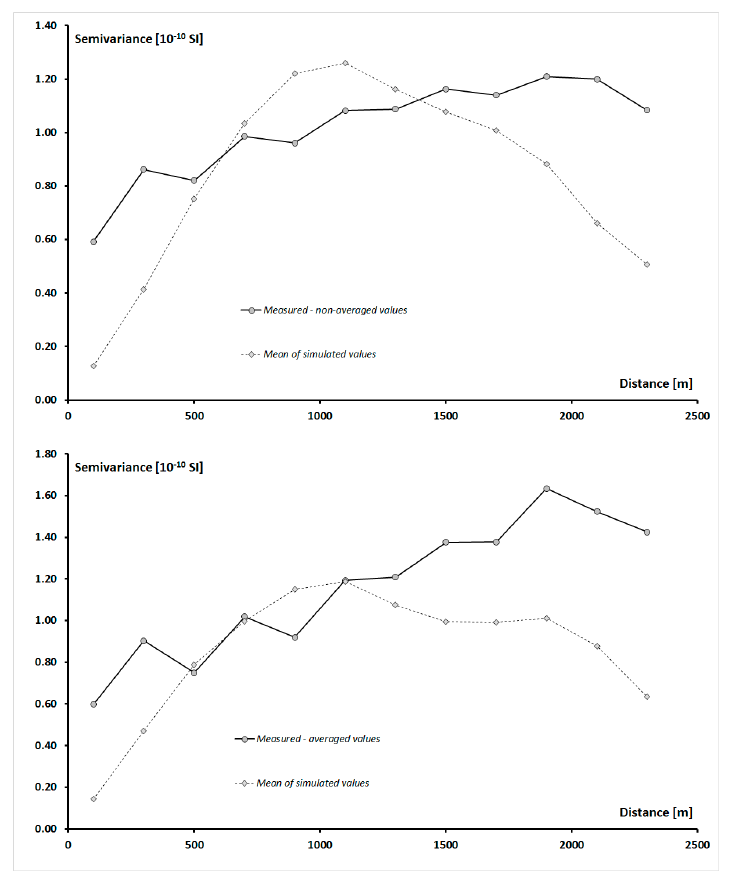
Figure 6. Experimental variograms of measured and simulated values of soil magnetic susceptibility using κ non-avg data (upper figure) and κ avg (bottom figure).